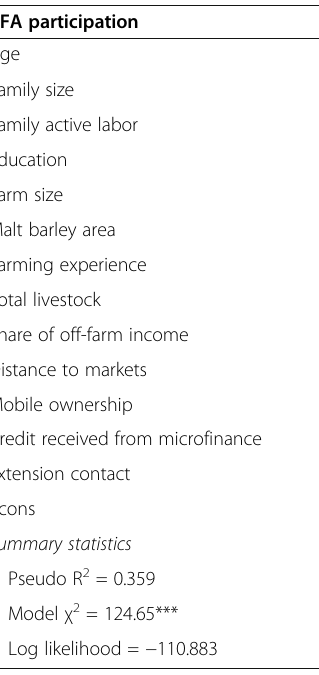
Table 2 Determinants of farmers ’ decision to participate in CFA CFA participation Coefficient Std. error z P > |z| Age